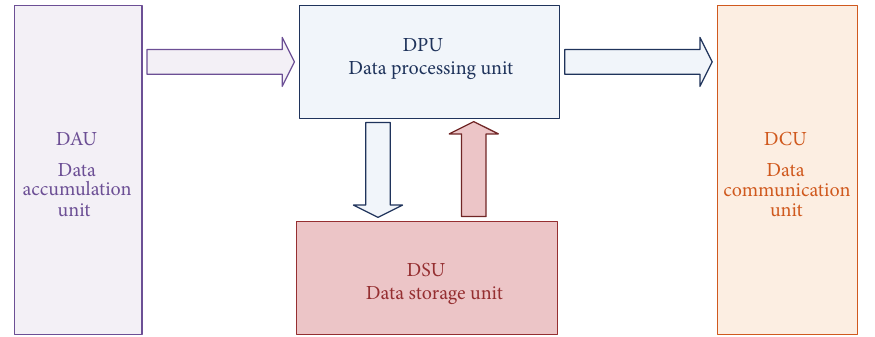
Figure 1: Four basic functional units of a